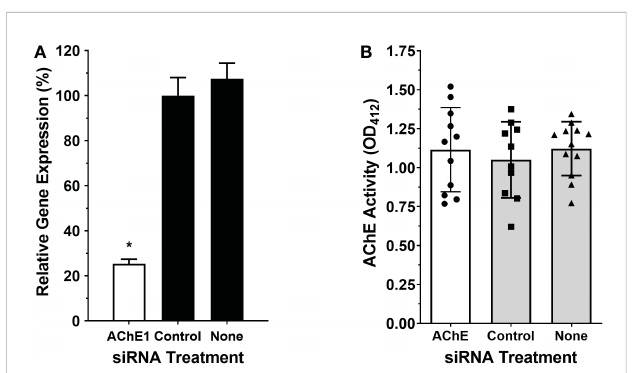
FIGURE 2 Suppression of SmAChE1 gene expression. Adult male parasites were treated either with an siRNA targeting SmAChE1, or with an irrelevant siRNA (Control) or with no siRNA (None), as indicated. (A) Relative expression of the SmAChE1 gene, measured by RT-qPCR seven days later. Treating parasites with siRNA targeting SmAChE1 signi fi cantly suppressed the expression of this gene (by ~ 70%; white bar, *p < 0.05 ANOVA) compared to controls. (B) AChE activity was measured in live individual male parasites treated with siRNA, as indicated. Mean AChE activity of the three groups of parasites did not differ signi fi cantly when tested 7 days post siRNA treatment. Each point represents data from an individual parasite, and the bars indicate the mean ( ± SD) for the group.